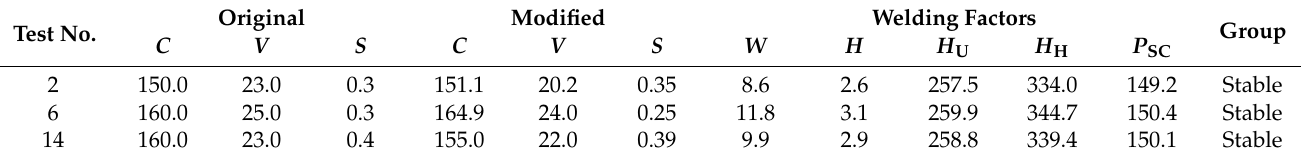
Table 13. Improvement through optimization.